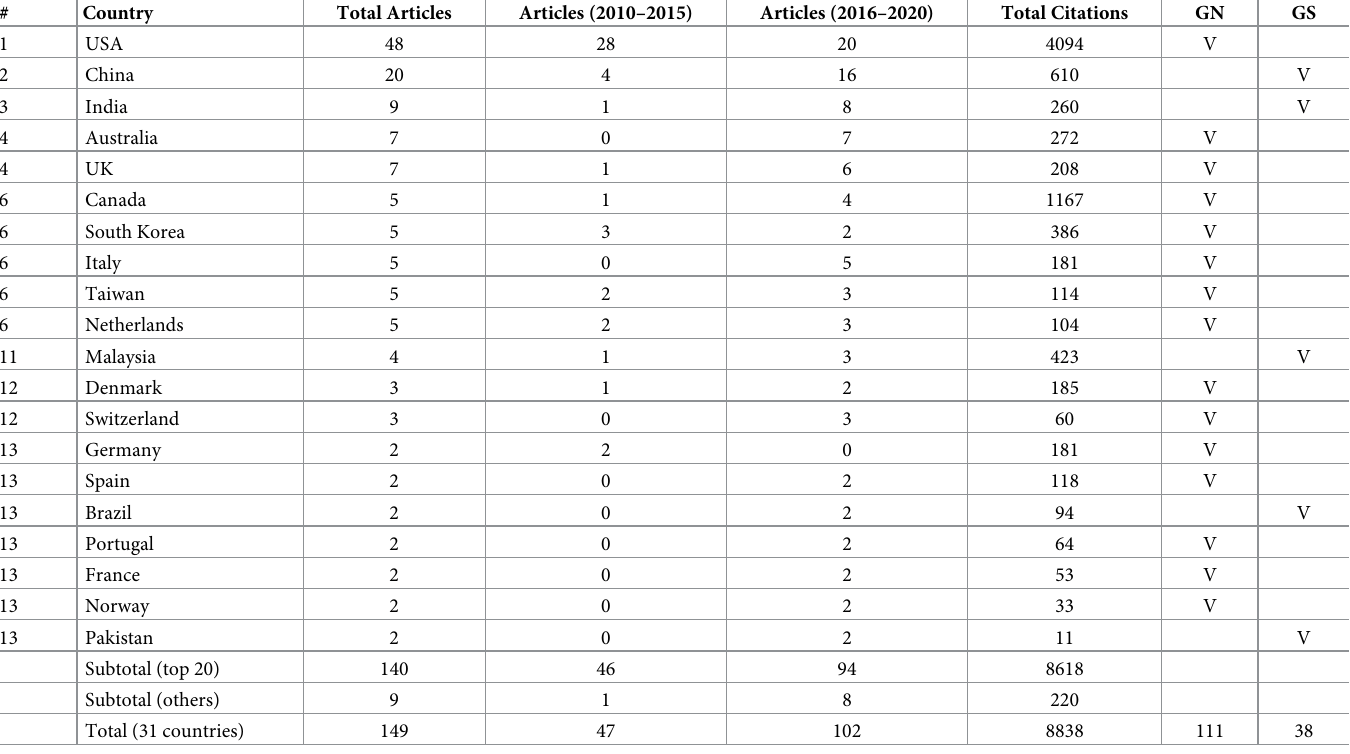
Table 1. Top 20 most productive countries in terms of AI research in information science